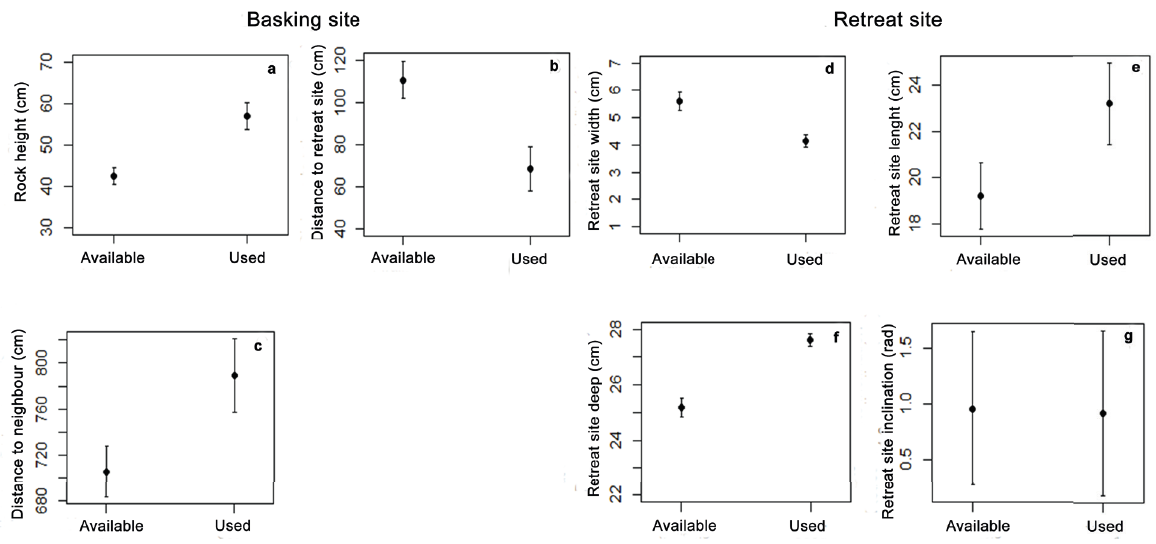
Figure 3. Mean and standard error plot of available versus used resource units for basking sites and retreat sites. For basking sites a) Rock height (available = 42.5 ± 1.9 cm; used = 56.9 ± 3.3 cm); b) Distance to retreat site (available = 110.6 ± 8.5 cm, used = 68.5 ± 10.7 cm) and c) Distance to neighbour perch (available = 705.3 ± 22.4 cm, used = 789.3 ± 32 cm). For retreat sites d) Retreat site width (available = 5.6 ± 0.3 cm; used = 4.14 ± 0.2 cm); e) Retreat site length (available = 19.2 ± 1.4 cm; used = 23.2 ± 0.2 cm); f) Retreat site deep (available = 25.2 ± 1.2 cm; used = 37.6 ± 1.7 cm) and, g) Retreat site inclination (available = 0.95 ± 0.07 rad; used = 0.91 ± 0.1 rad). Table II. The best model of basking site and retreat site selection for Phymaturus palluma. Coeffi cients, standard error (SE), selection ratio (>1 selected resource, <1 avoided resource), probability of selection (%), probability (P) and confi dence intervals (CI) with 0.95 of signifi cance.